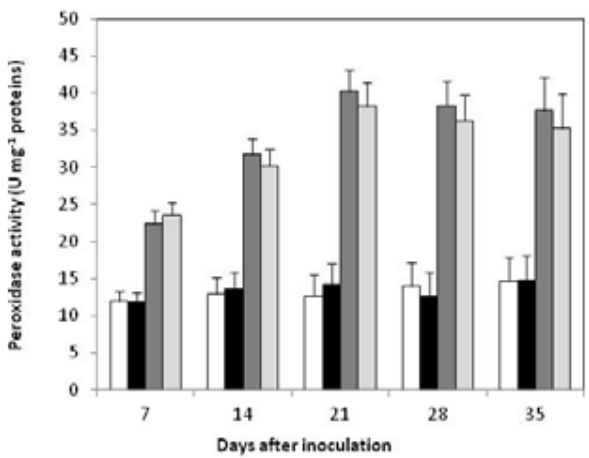
Figure 2. Peroxidase activities in chickpea roots inoculated with Rhizobium strain Pch AZM and infested by Orabanche foetida . Activities were measured at 7, 14, 21, 28 and 35 d af- ter inoculation with rhizobia and infection with Orobanche (light grey). Experimental controls were with healthy chickpeas ( ) singly inoculated (dark gray) or singly in- fected with O. foetida ( )